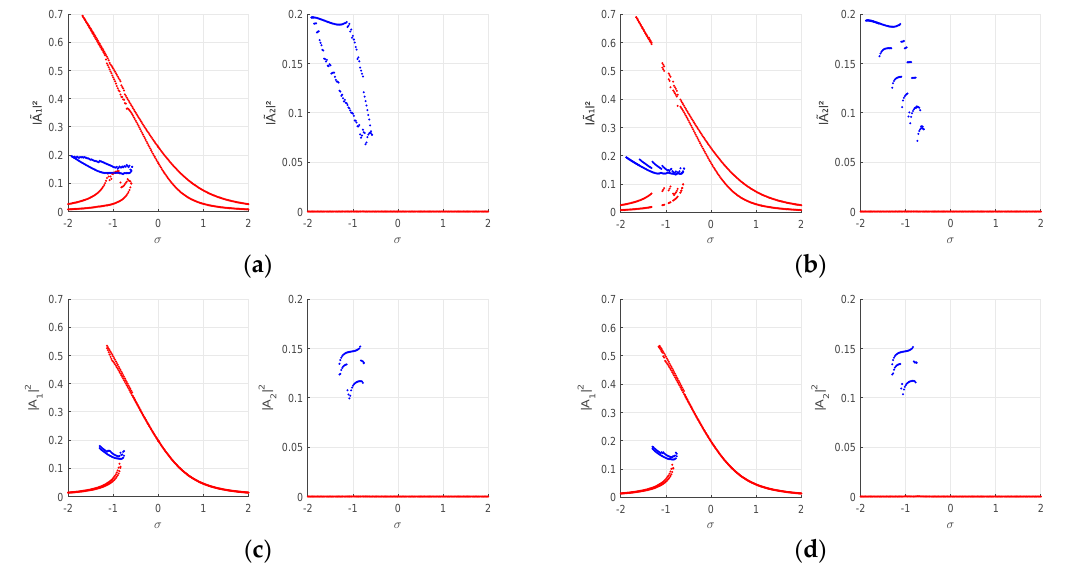
Figure 5. Envelopes of the amplitudes ( a , b ) (cid:3627)(cid:1827)(cid:4634) (cid:2869) (cid:3627) and ( c , d ) |(cid:1827) (cid:2869) | (cid:2870) and |(cid:1827) (cid:2870) | (cid:2870) of the second pendulum modal response computed using the LHS and gPCE methods, respectively, for (cid:2012) (cid:3039) = 5% .